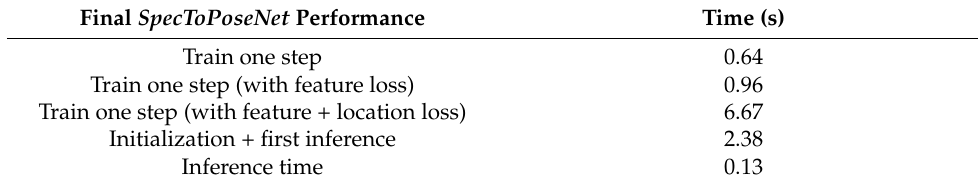
Table 4. Training and inference time of the SpecToPose